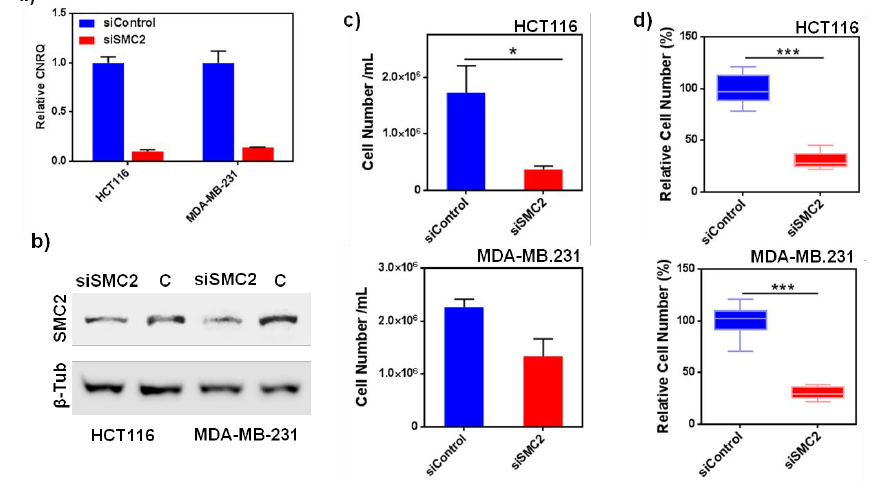
Figure 1. SMC2 siRNA inhibition. ( a ) Relative mRNA levels after SMC2 silencing for HCT116 and MDA-MB231 cell lines (siSMC2). Fold change is represented with respect to mRNA levels obtained from non-relevant siRNA-treated cells (siControl); ( b ) SMC2 and beta tubulin proteins detected by Western blot after SMC2 silencing (siSMC2) and compared to non-relevant siRNA-treated cells C; ( c ) cell viability assay for HCT116 and MDA-MB-231 adherent cells after treatment with siRNA against SMC2 (siSMC2) and with a scrambled control siRNA (siControl); and ( d ) cell viability assay for HCT116 and MDA-MB-231 growing in non-adherent conditions as tumorspheres, after treatment with siRNA against SMC2 (siSMC2) and with a scramble control siRNA (siControl). * p < 0.05, *** p < 0.001.